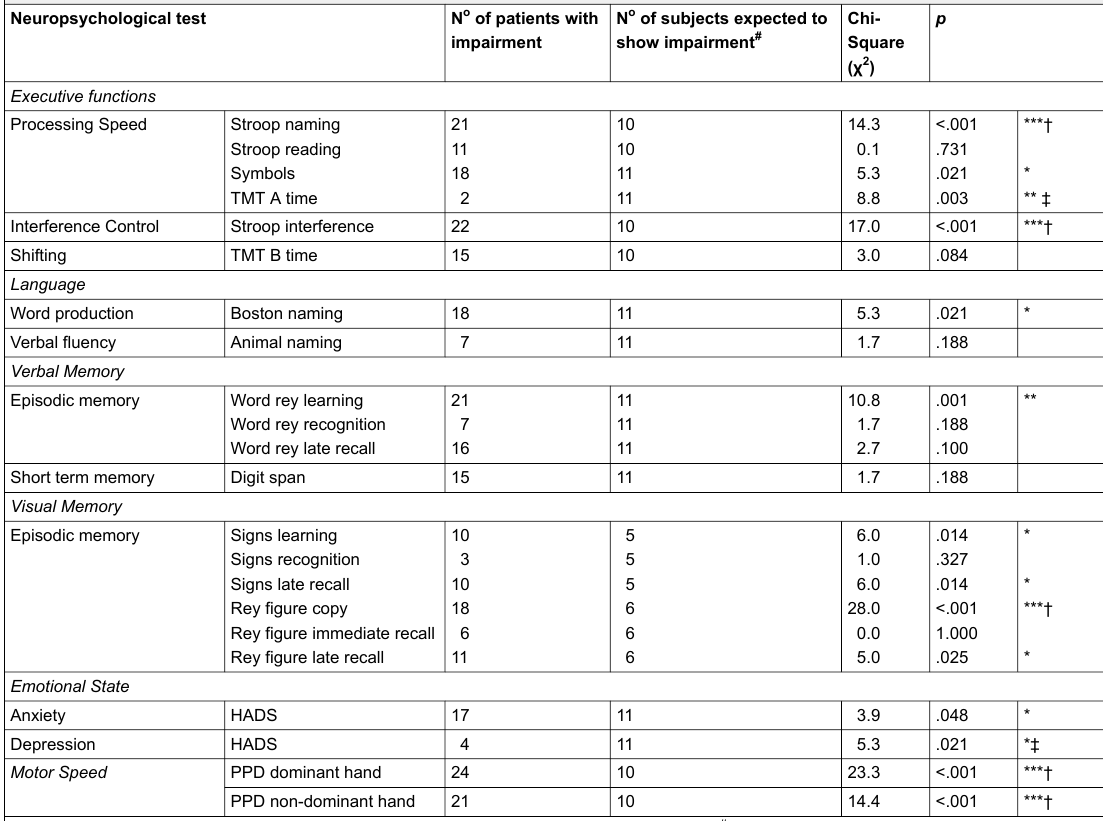
Table 4: Significant differences between observed and expected cognitive